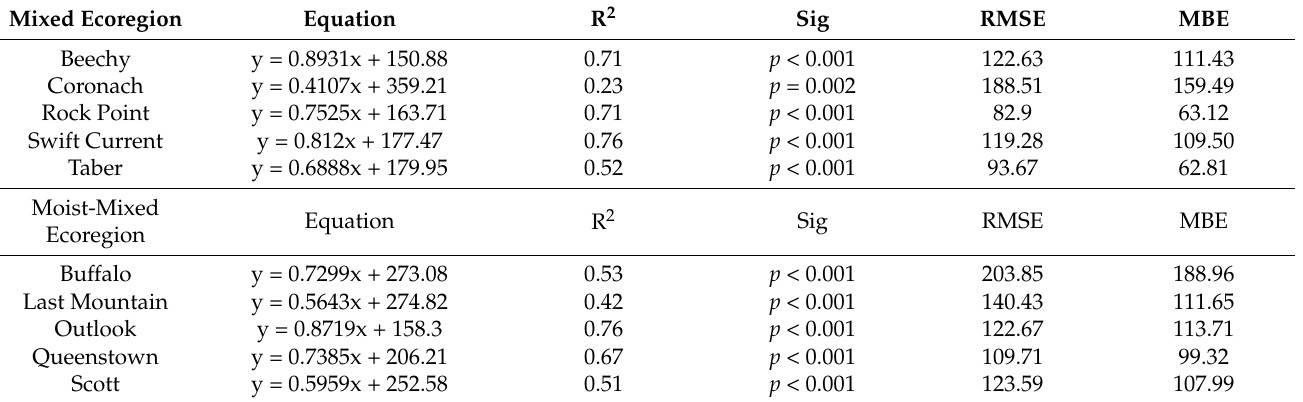
Table 3. Linear regression between the observed data and ERA5-ECMWF (mm.yr-1) for the weather stations located in the Mixed Ecoregion and in the Moist = Mixed